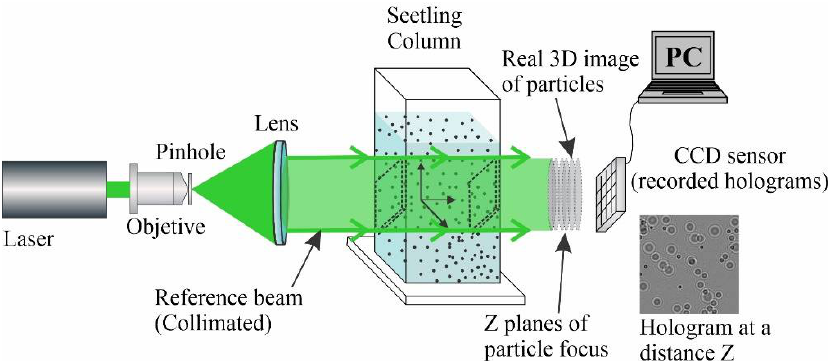
Figure 3. In-line Digital Holography set